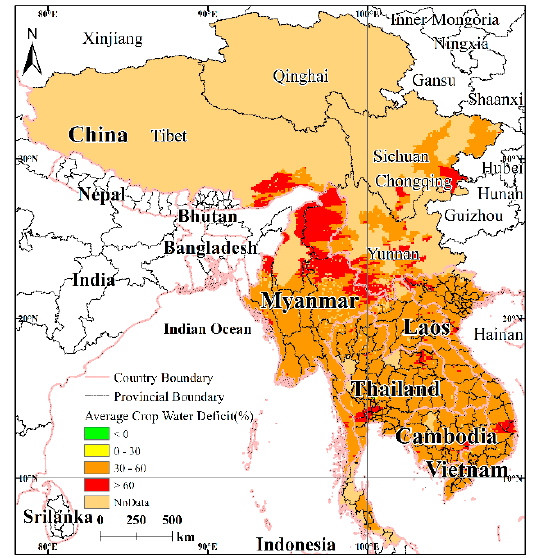
Figure 10. Water deficiency in the average growing season for crops.